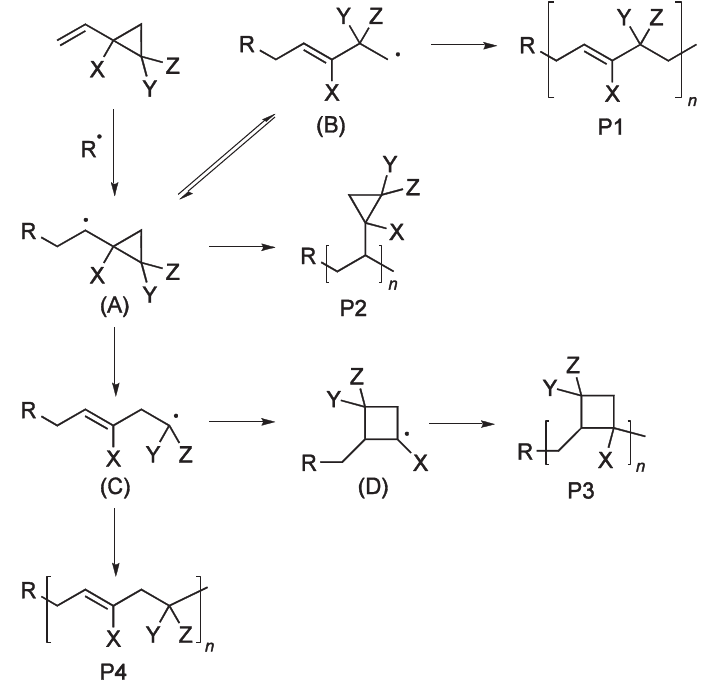
Figure 2. The RROP of vinyl cyclopropane showing the competing reaction